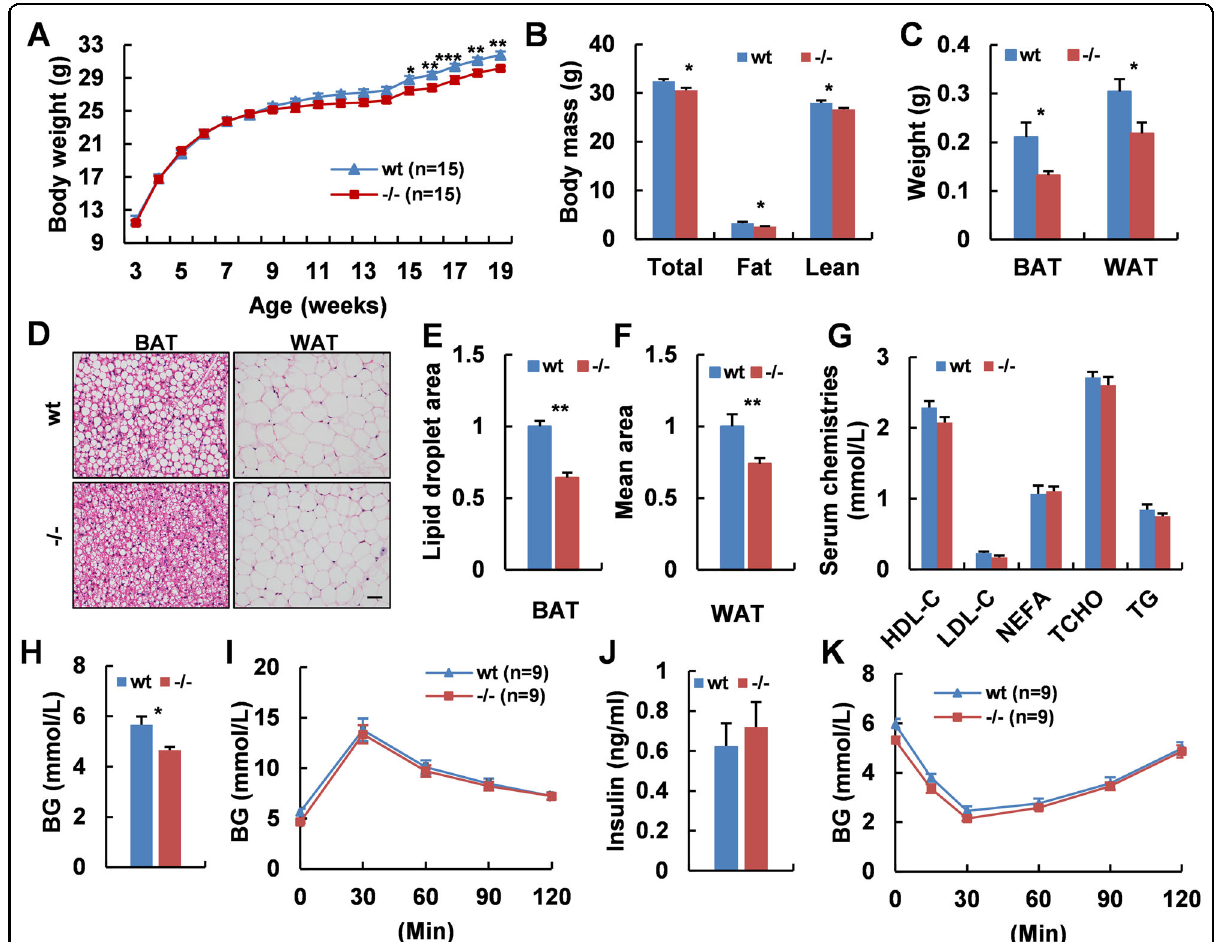
Fig. 1 Adgra1 de fi ciency causes decreased body weight in chow-fed male mice. A Body weight curves of Adgra1 − / − male mice and their littermate controls, n = 15/group. B Body mass (total, fat, and lean weight) of Adgra1 − / − male and control mice, n = 8 – 9/group. C Weights of adipose tissues in Adgra1 − / − male and control mice, n = 5/group. D Representative images of HE stained BAT, and WAT from Adgra1 − / − male and control mice. Scale bar, 50 μ m, n = 5/group. E Quantify of the lipid droplet-positive area in the BAT, n = 5/group. F Quantify of the mean area of the adipocytes in the WAT, n = 5/group. G Serum chemistries in Adgra1 − / − male and wt mice in fed state, n = 9/group. H Basal blood glucose levels after fasted overnight of Adgra1 − / − male and control mice, n = 9/group. I GTT in Adgra1 − / − male and wt mice, n = 9/group. J Serum insulin levels of Adgra1 − / − male and control mice, n = 9/group. K ITT in Adgra1 − / − male and wt mice, n = 9/group. BG blood glucose. * p < 0.05, ** p < 0.01, *** p < 0.001 vs. controls. Data represent mean ±